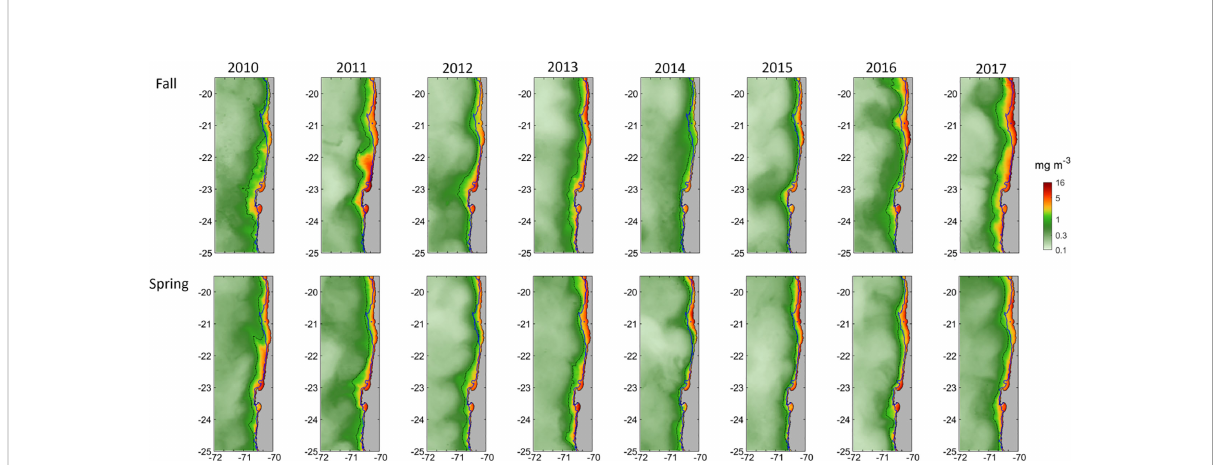
FIGURE 3 Monthly mean satellite chlorophyll-a (mg m -3 ) of every April (representative of fall, upper panels) and December (representative of spring, lower panels). The black dotted line indicates the 1 mg m -3 isoline, whereas the blue line indicates the 200 m